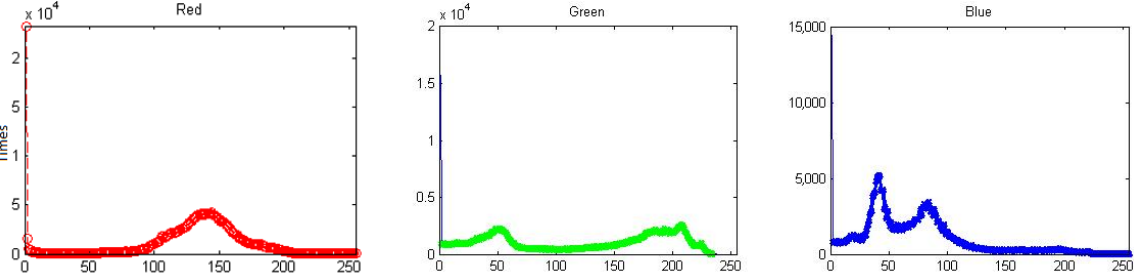
Figure 3. Average histogram of RGB pixel value distribution of 200 capsule endoscopy